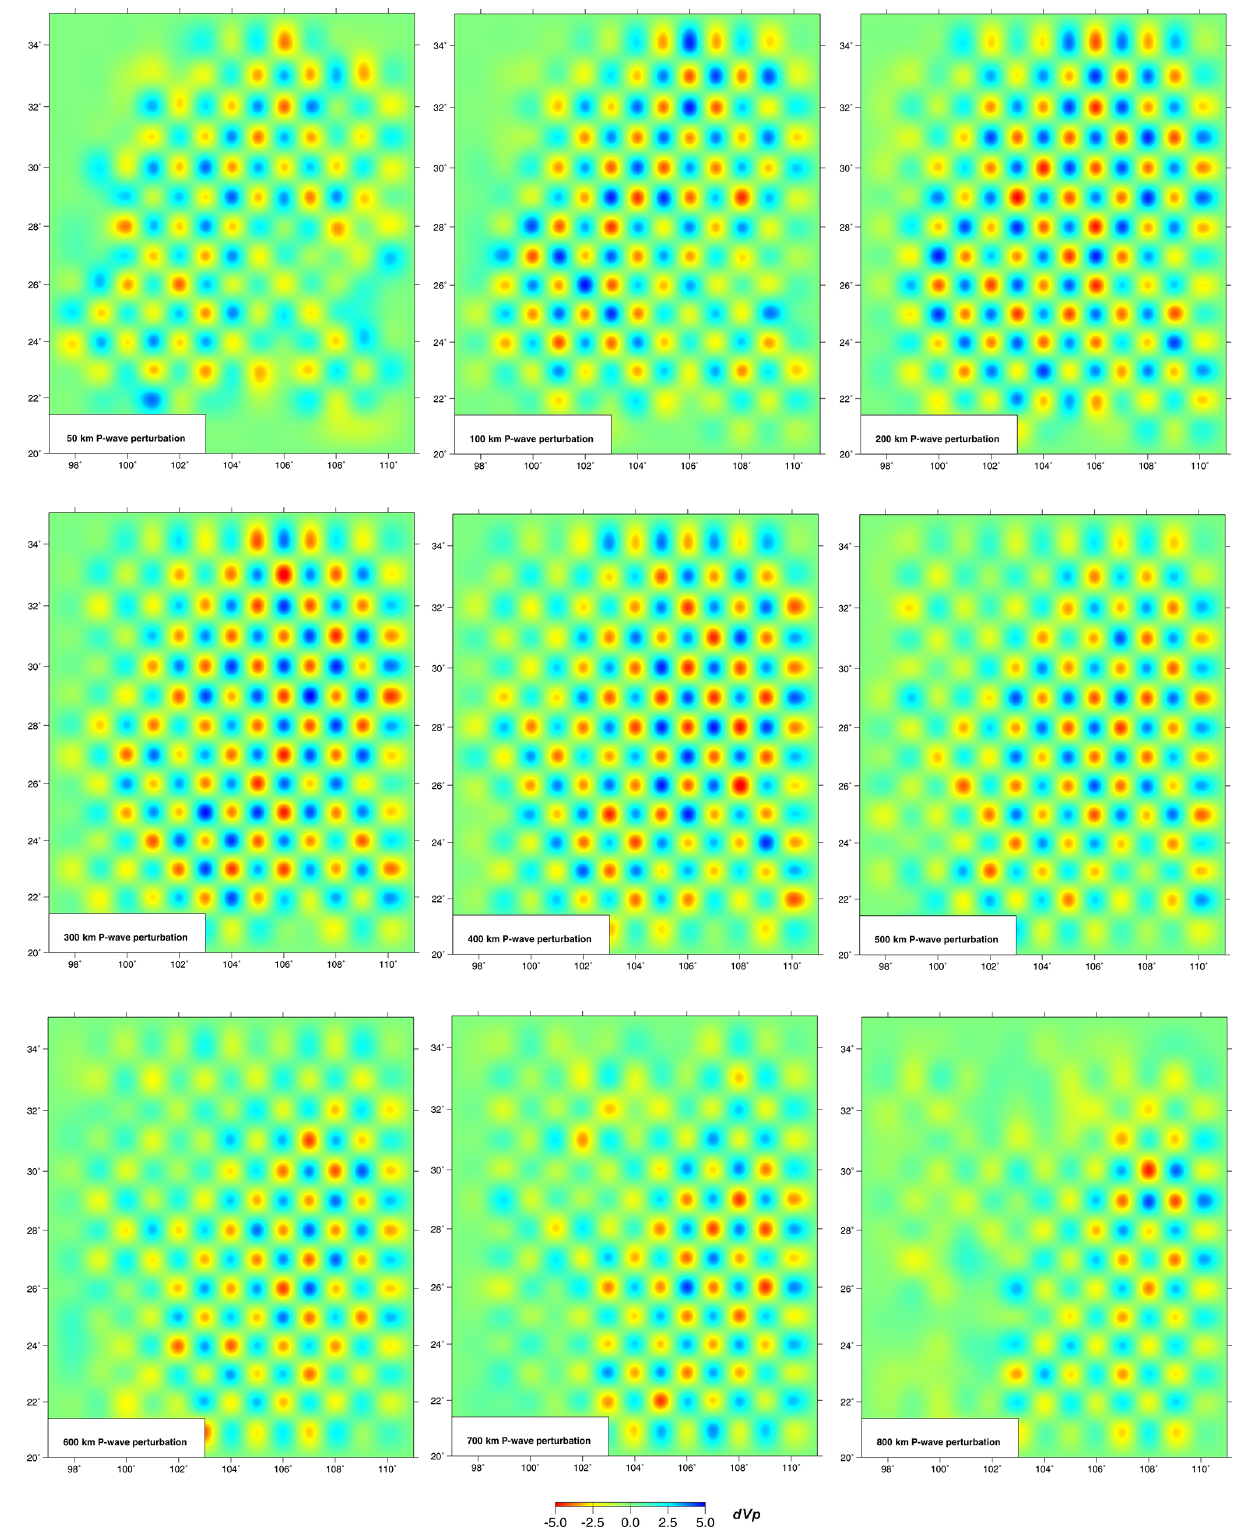
Figure 5. Checkerboard resolution test at 50, 100, 200, 300, 400, 500, 600, 700, and 800km depth sections relative to the IASP91 1-D velocity model (Kennett and Engdahl, 1991). The model was run using the same stations or events as the main inversion, with the same damping